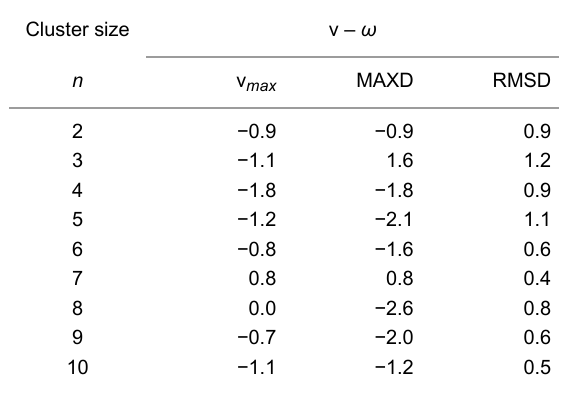
the features of the high-level PBE/VDB potential energy surfaces. It is therefore used to pre-scan PES in the fast-VSCF method. The right part of Figure 11 shows a plot of the binding energies for the various DFT approaches and MP2/SBKJC(1 f ), compared to energy values reported in other studies and to available experimental values.